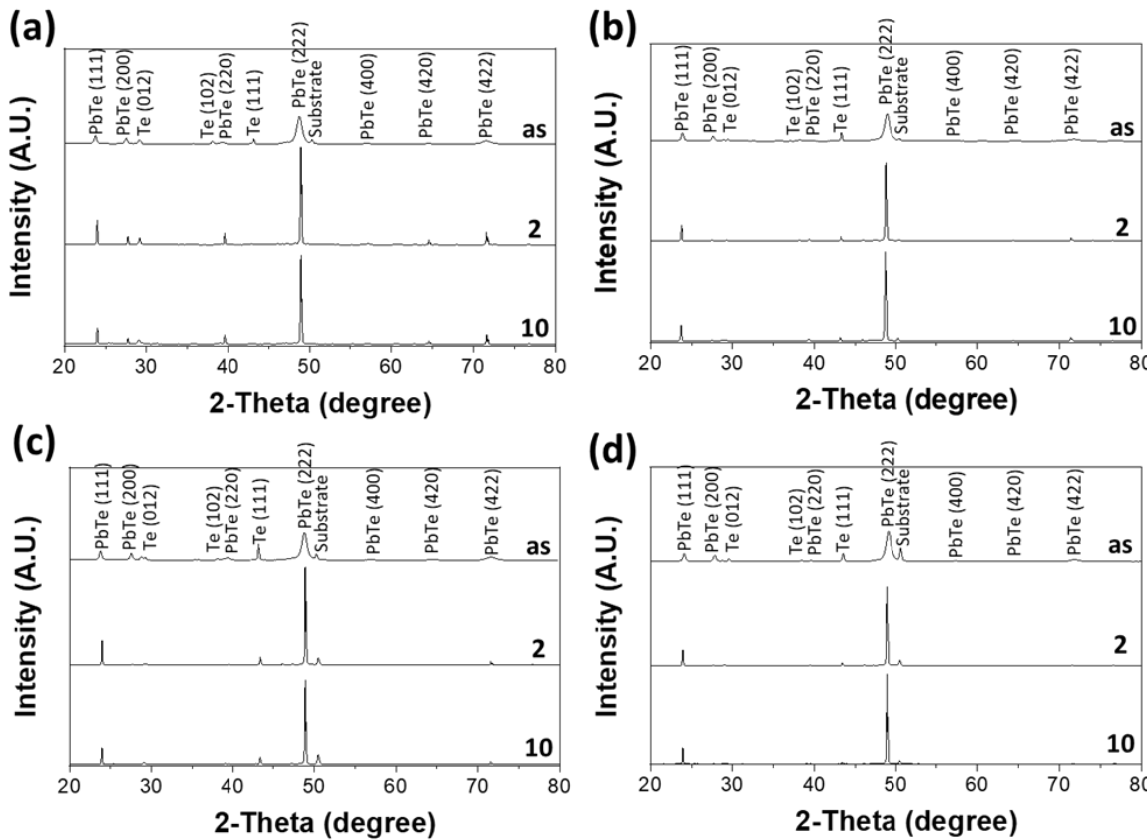
Figure 2. XRD analysis of as deposited and annealed at 200 °C for 2 and 10 h. The PbTe films were electrodeposited at different applied potential of ( a ) − 0.9, ( b ) − 0.95, ( c ) − 1.0 and ( d ) − 1.05 V with 550 mM (TeO 32 − ), 100 mM (Pb 2+ ), and [EDTA 4 − ]/[Pb 2+ ] of 7.5 at pH of 12.3 and temperature of 23 °C.